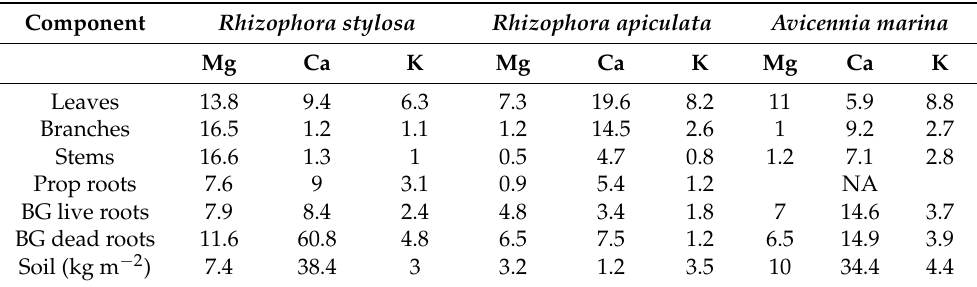
Table 3. Mean concentrations (mg g − 1 DW) of Mg, Ca, and K in different tree components in three mangrove species. Soils were sampled to the depth of maximum root penetration. R. stylosa and A. marina were in Western Australia in the arid tropics and R. apiculata was in southern Thailand in the humid tropics. NA = not applicable. Source: